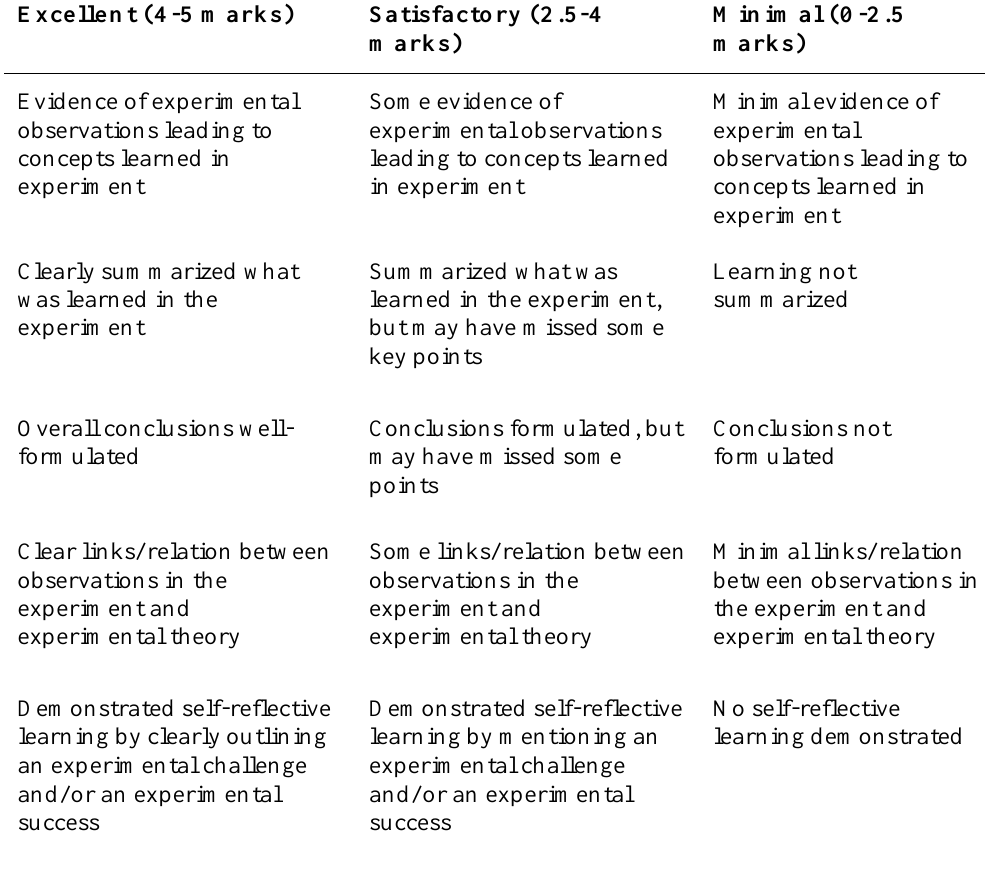
Rubric for Evaluating Reflective Learning Journal